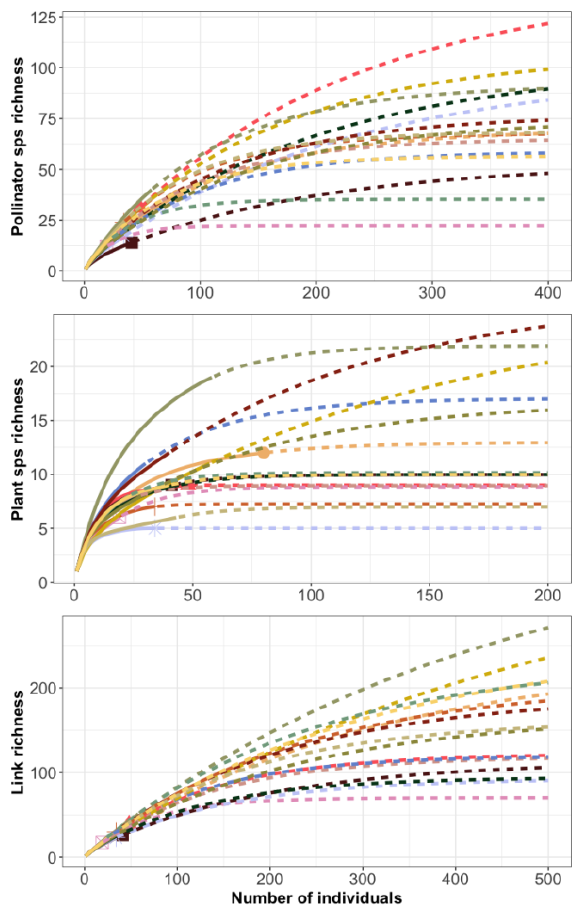
Figure S3. Accumulation curves of pollinator, plant and plant-pollinator link richness with increasing sampling effort up to 100% sample coverage. Solid lines and points indicate observed richness while dashed lines show expected richness at increasing sample size, (i.e., extrapolated).